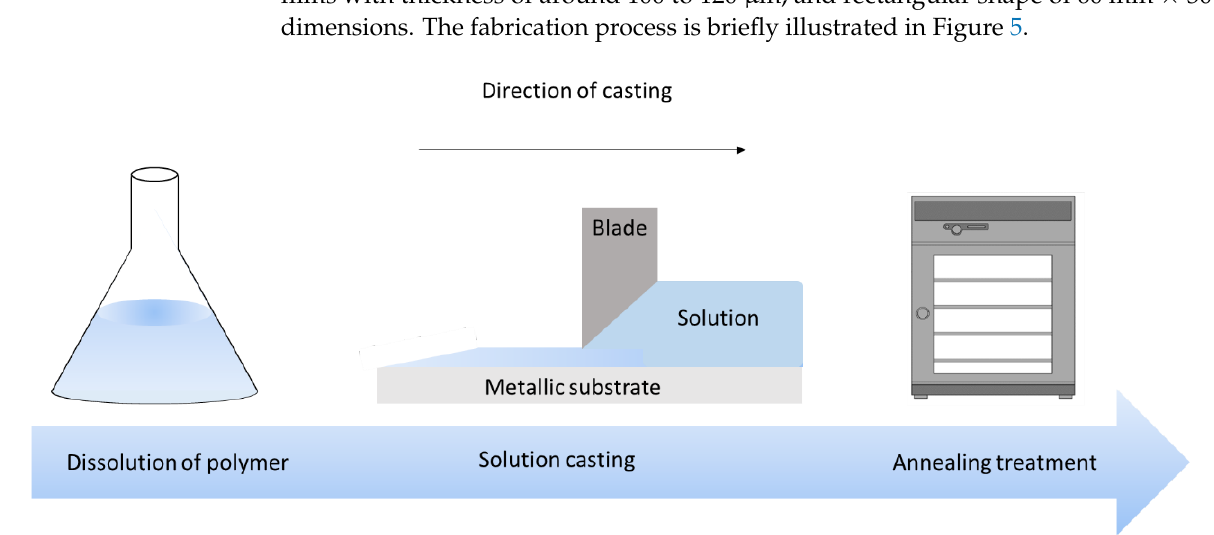
Figure 4. Representation of material performances for electroadhesion: ( a ) Dielectric Constant ( b ) Maxwell Pressure.